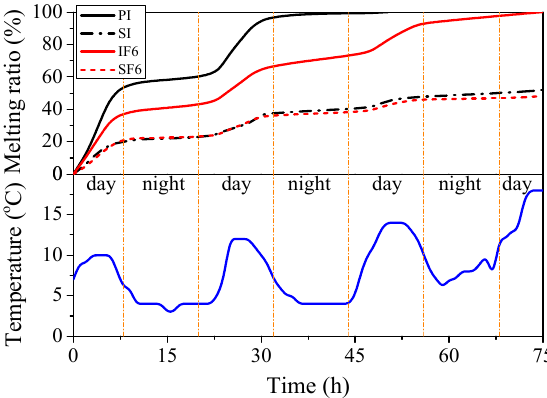
Figure 15. Melting rate of representative specimens and variation of temperature with increasing time.